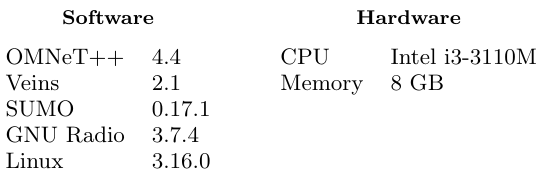
Figure 6: The frame reception rate with respect to the signal-to-noise ratio of the deterministic sig- nal simulation (red) compared to Veins’ stochastic model (blue).